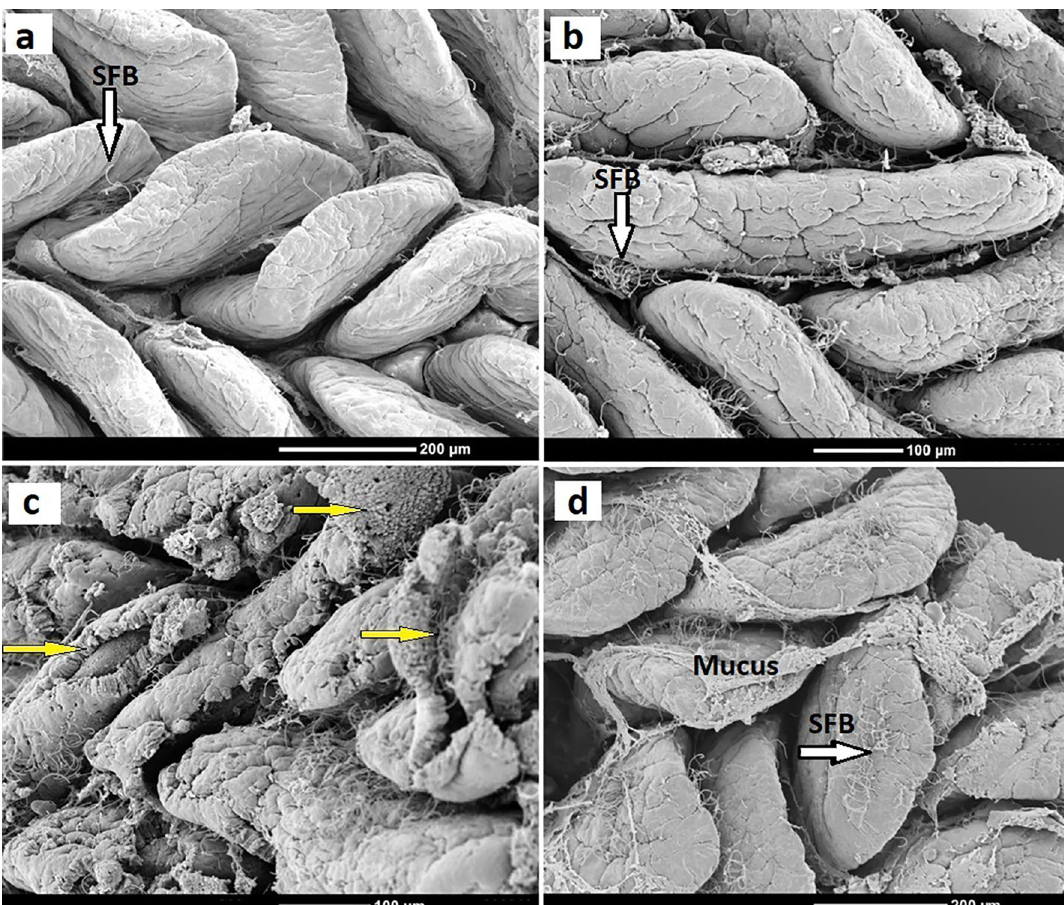
Figure 6. Scanning electron micrographs of ileal mucosa of 21 d old chicks demonstrating SFB, mucus and villus damage. Images looking from the top of mucosa, with examples showing segmented filamentous bacteria (SFB) colonization on the ileal villi (white arrows): low abundance of SFB ( a ) from a control chick, moderate abundance of SFB ( b ) from a H57 chick, and high abundance of SFB ( c , d ) from a NE-challenged and NE-H57 chick, respectively. Shown with yellow arrows are villi damage ( c ) in a NE-challenged chick, and mucus layer ( d